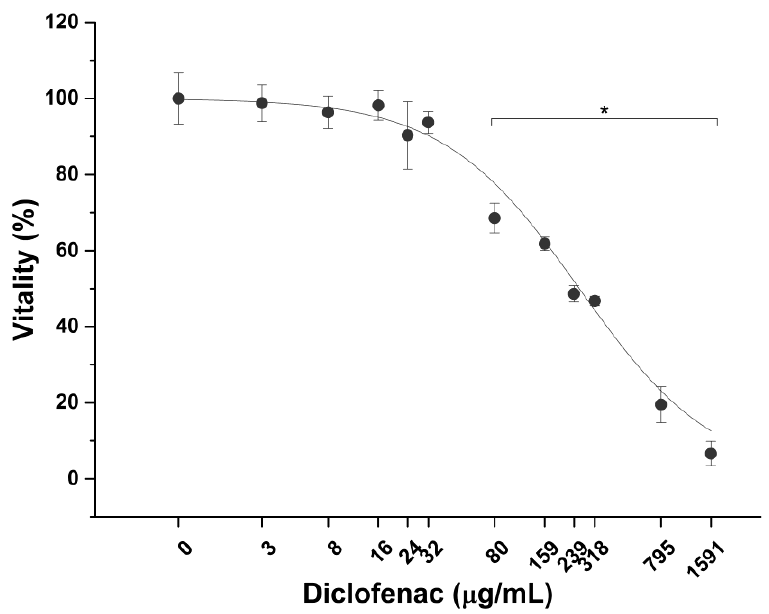
Figure 13. Effect of diclofenac on LNCaP prostatic cells vitality. * p < 0.05 ( n = 3).